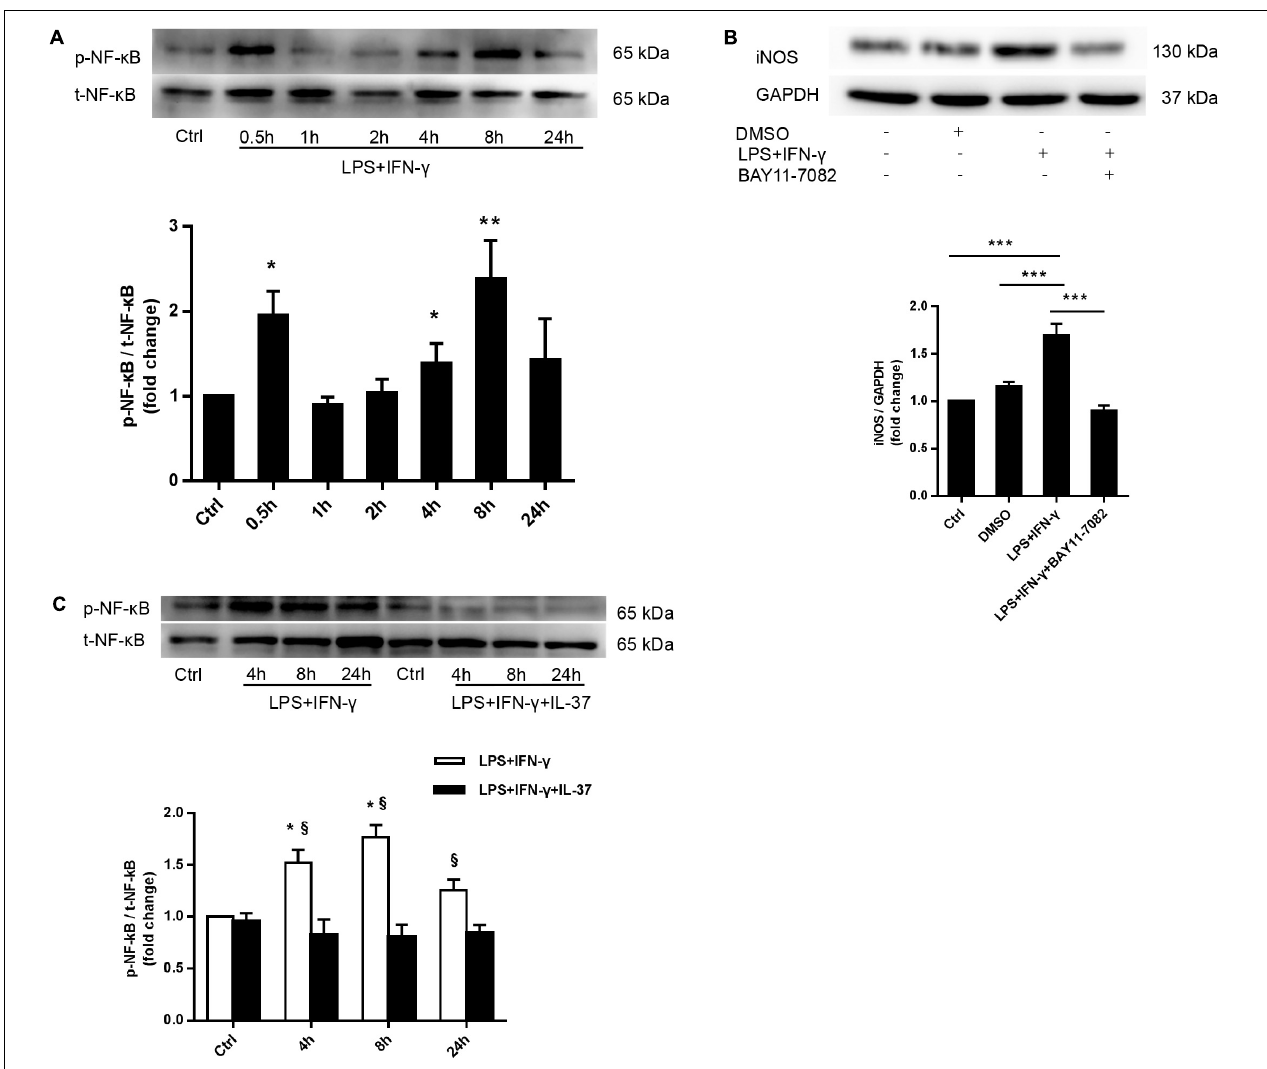
FIGURE 4 | IL-37 suppresses M1 polarization through the NF- κ B signaling pathway. (A) Representative immunoblots and densitometric data show that PMA-treated THP-1 cells exhibit enhanced NF- κ B phosphorylation after treatment with LPS (100 ng/ml) and IFN- γ (20 ng/ml) for 0.5 to 24 h; n = 3, * P < 0.05, ** P < 0.01 vs. corresponding control. (B) PMA-treated THP-1 cells were treated with BAY11-7082 (5 µ M) 1 h prior to being treated with LPS (100 ng/ml) and IFN- γ (20 ng/ml). Representative immunoblots and densitometric data show that NF- κ B pathway inhibition decreases iNOS expression in M1 macrophages; n = 3, *** P < 0.001. (C) PMA-treated THP-1 cells were treated with LPS (100 ng/ml) and IFN- γ (20 ng/ml) for 4–24 h in the presence or absence of recombinant IL-37 (0.1 ng/ml). Representative immunoblots and densitometric data show that treatment with recombinant IL-37 results in a reduction in NF- κ B phosphorylation at different time point; n = 3, * P < 0.05 vs. corresponding control, § P < 0.05 vs. M1 macrophages treated with